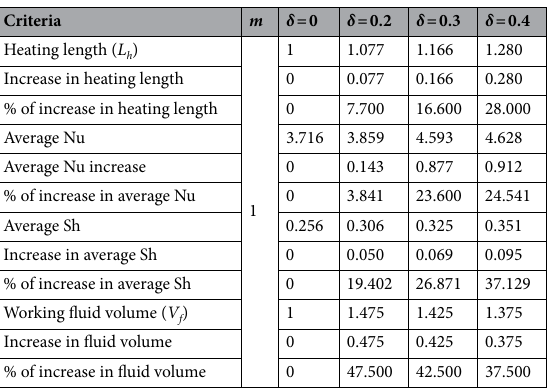
Table 6. Effect of increase in heating length ( L h ) by δ for Le = 1, Pe = 1, Gr = 10 4 , Da = 10 –3 , Ha = 30, γ = 60°.